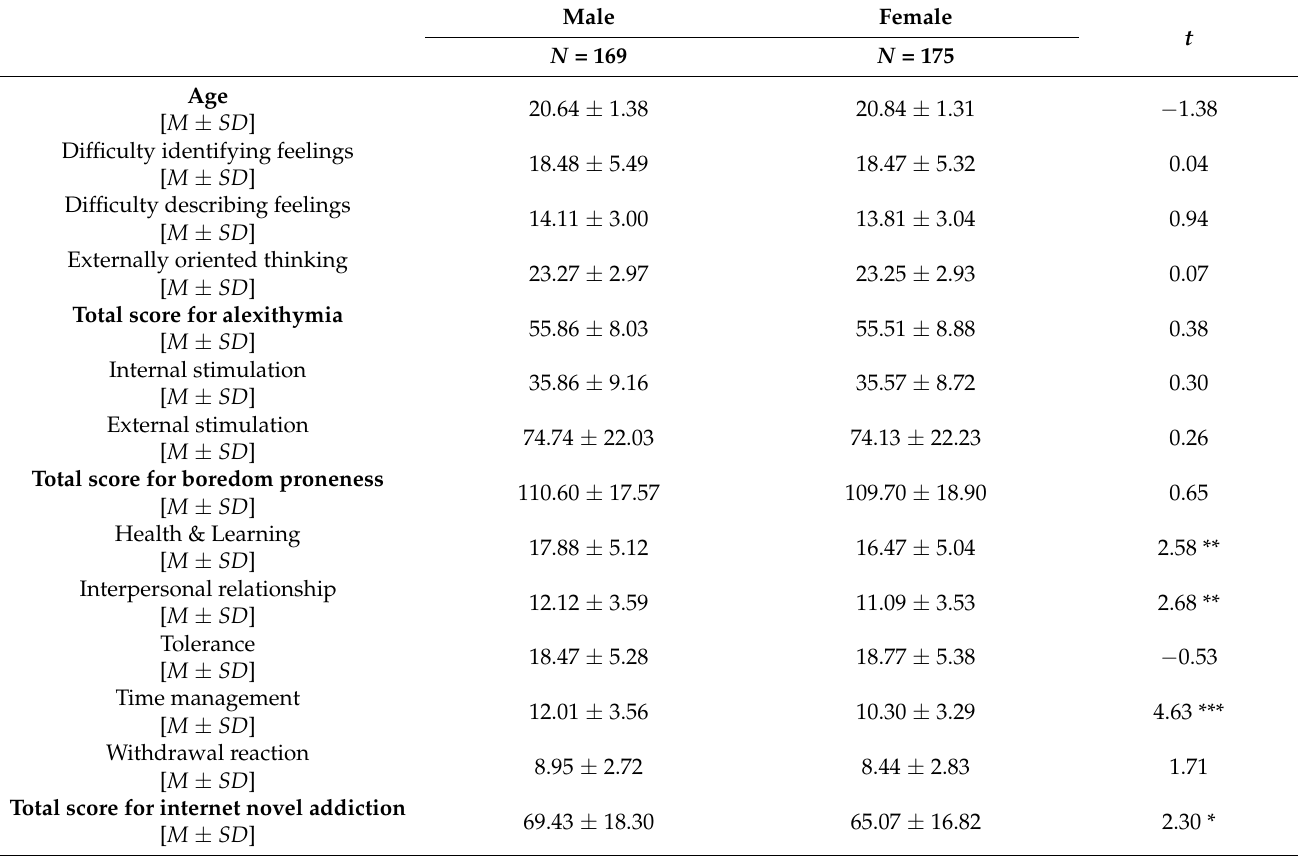
Table 1. Sex differences in alexithymia, boredom proneness, and internet novel addiction. Male